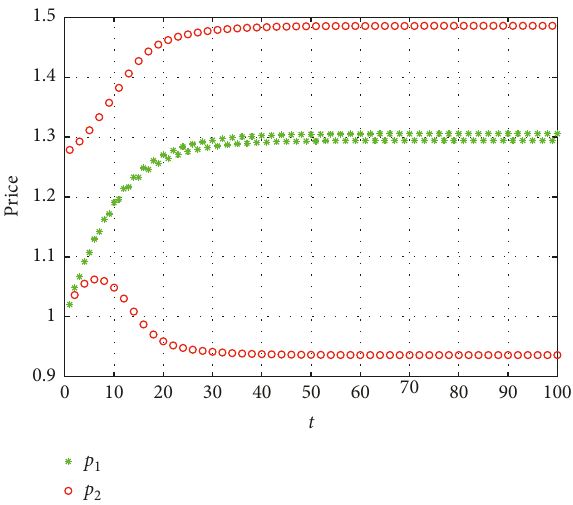
Figure 6: The current price adjustment speed diagram.